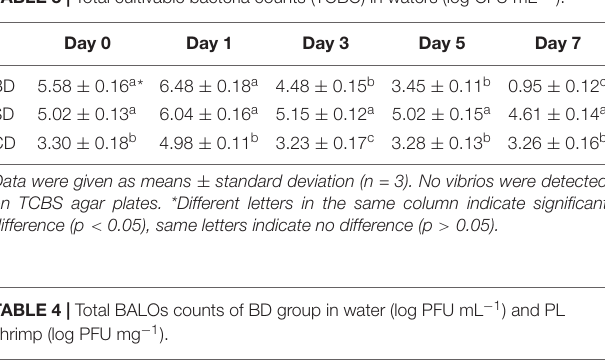
TABLE 3 | Total cultivable bacteria counts (TCBC) in waters (log CFU mL − 1 ).